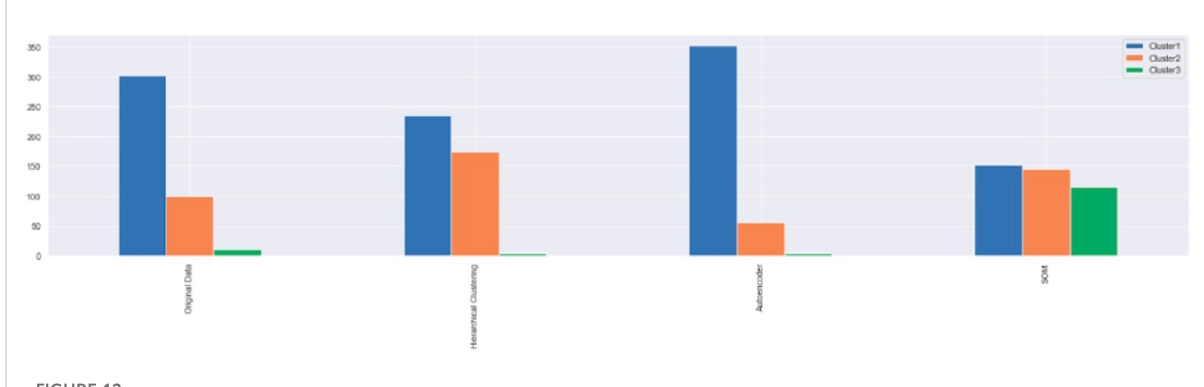
FIGURE 12 Proportion for each samples in each